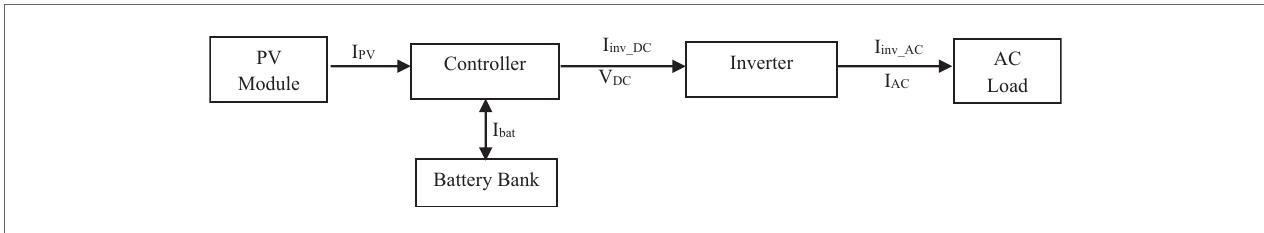
FigUre 4 | Model of the proposed PV-battery system (ani and ani, 2014) .